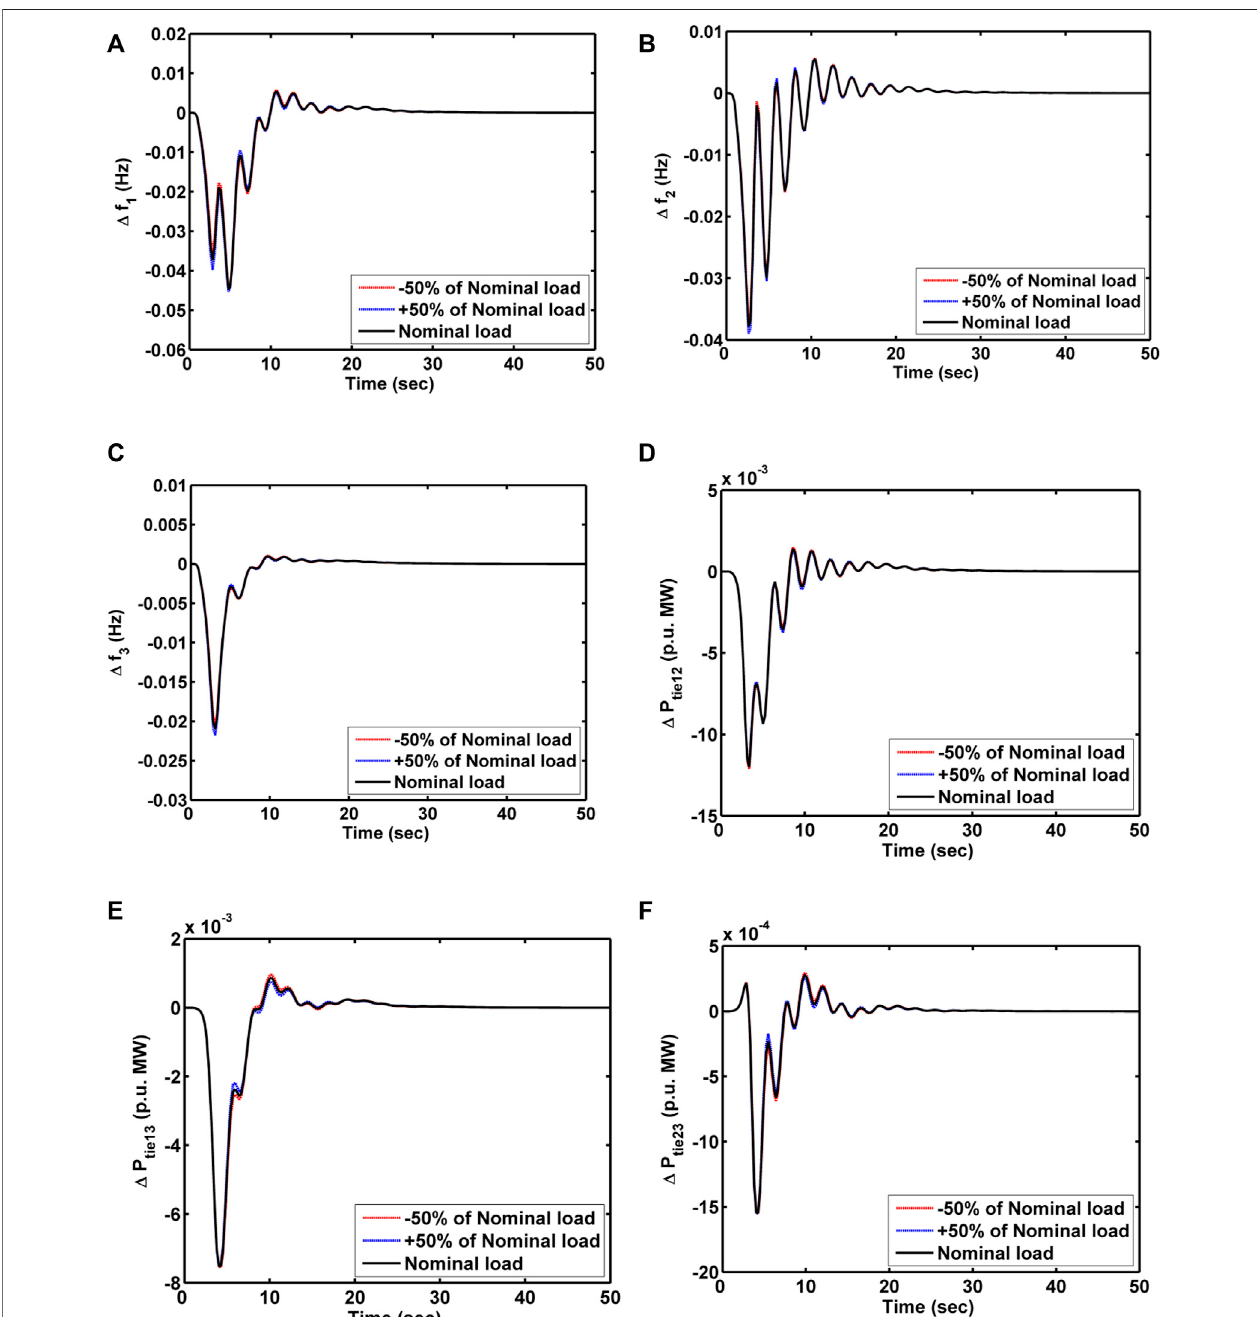
FIGURE 10 | Case 3 responses. (A) Δ f 1 , (B) Δ f 2 , (C) Δ f 3 , (D) Δ P tie12 , (E) Δ P tie13 , and (F) Δ P tie23